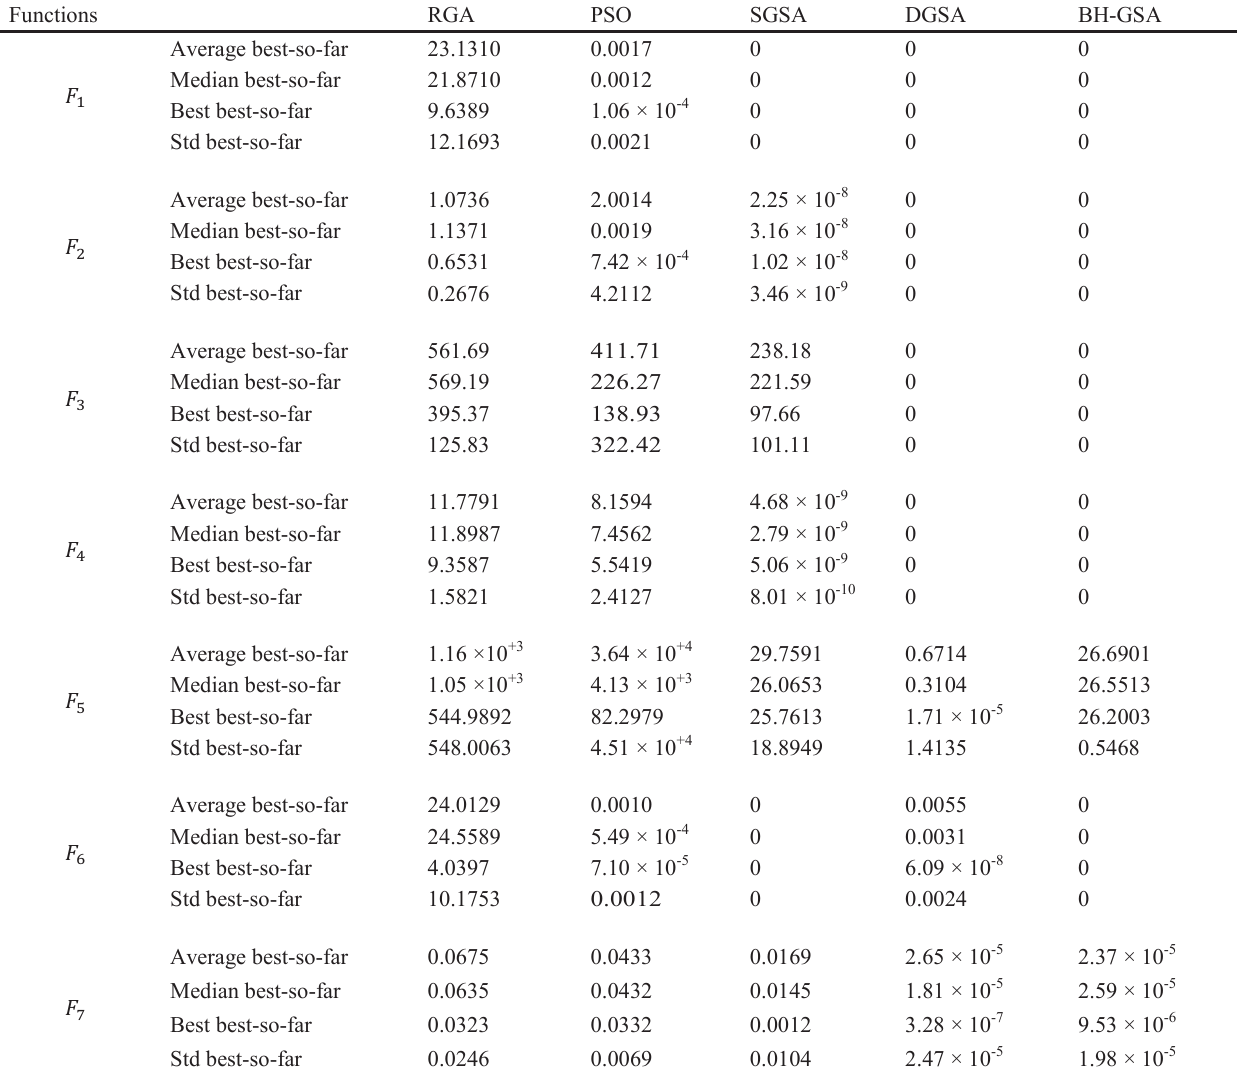
Table 4. Minimization result of benchmark functions in Table 1 with n = 30 and